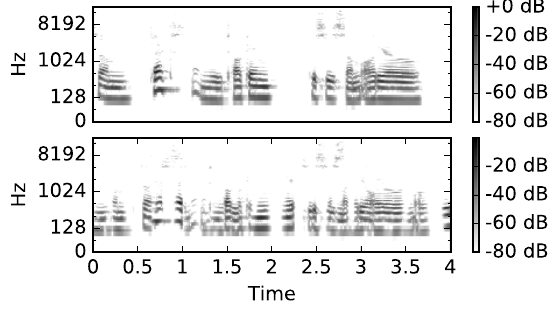
Figure 3. Power spectra for original signal (top), and sound- shredded signal